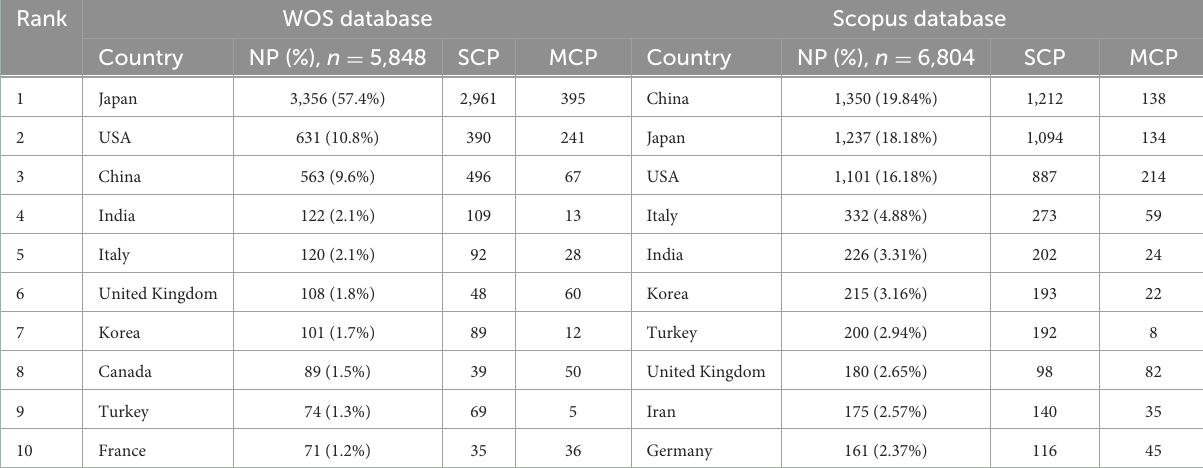
TABLE 4 The top 10 major publishing countries with KD research and their cooperative publishing proportion.